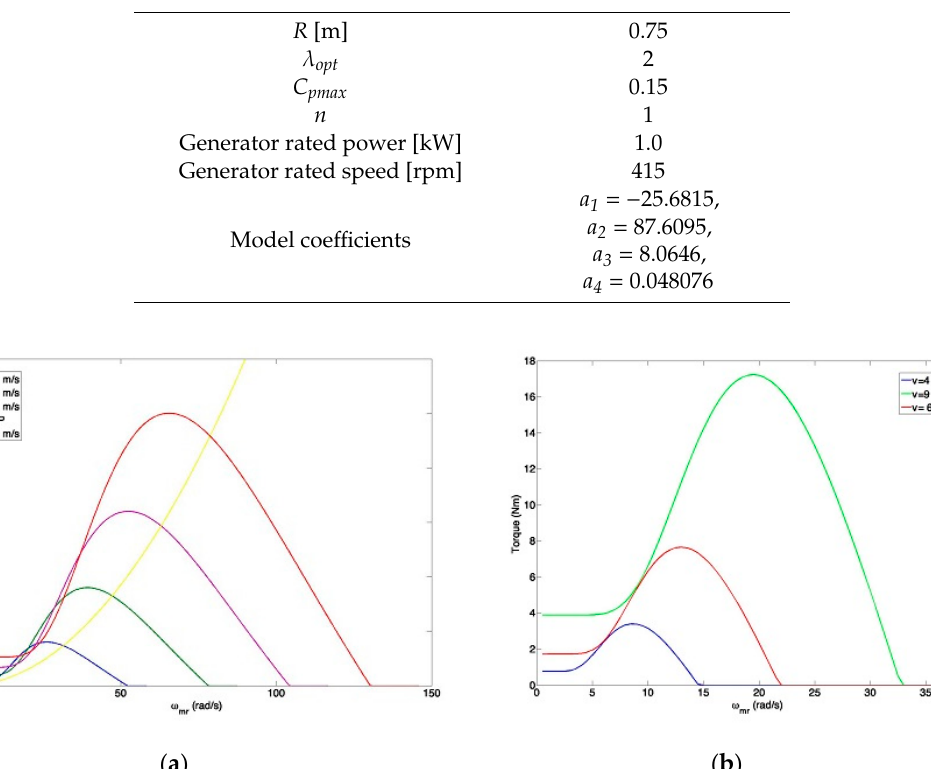
Figure 7. Neurons (red) and neuron connections (green) shown on the characteristic surface of turbine (gray): ( a ) torque versus wind speed versus angular speed for 5.5 kW HAWT; ( b ) power versus wind speed versus angular speed for 1 kW VAWT.